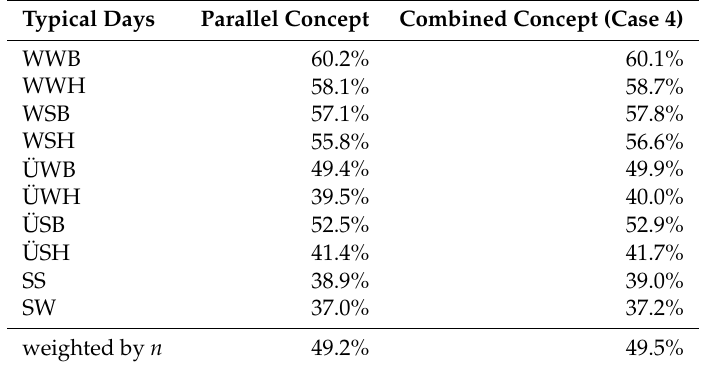
Table 7. Exergetic efficiency per typical day for combined (case 4) and parallel heat extraction.